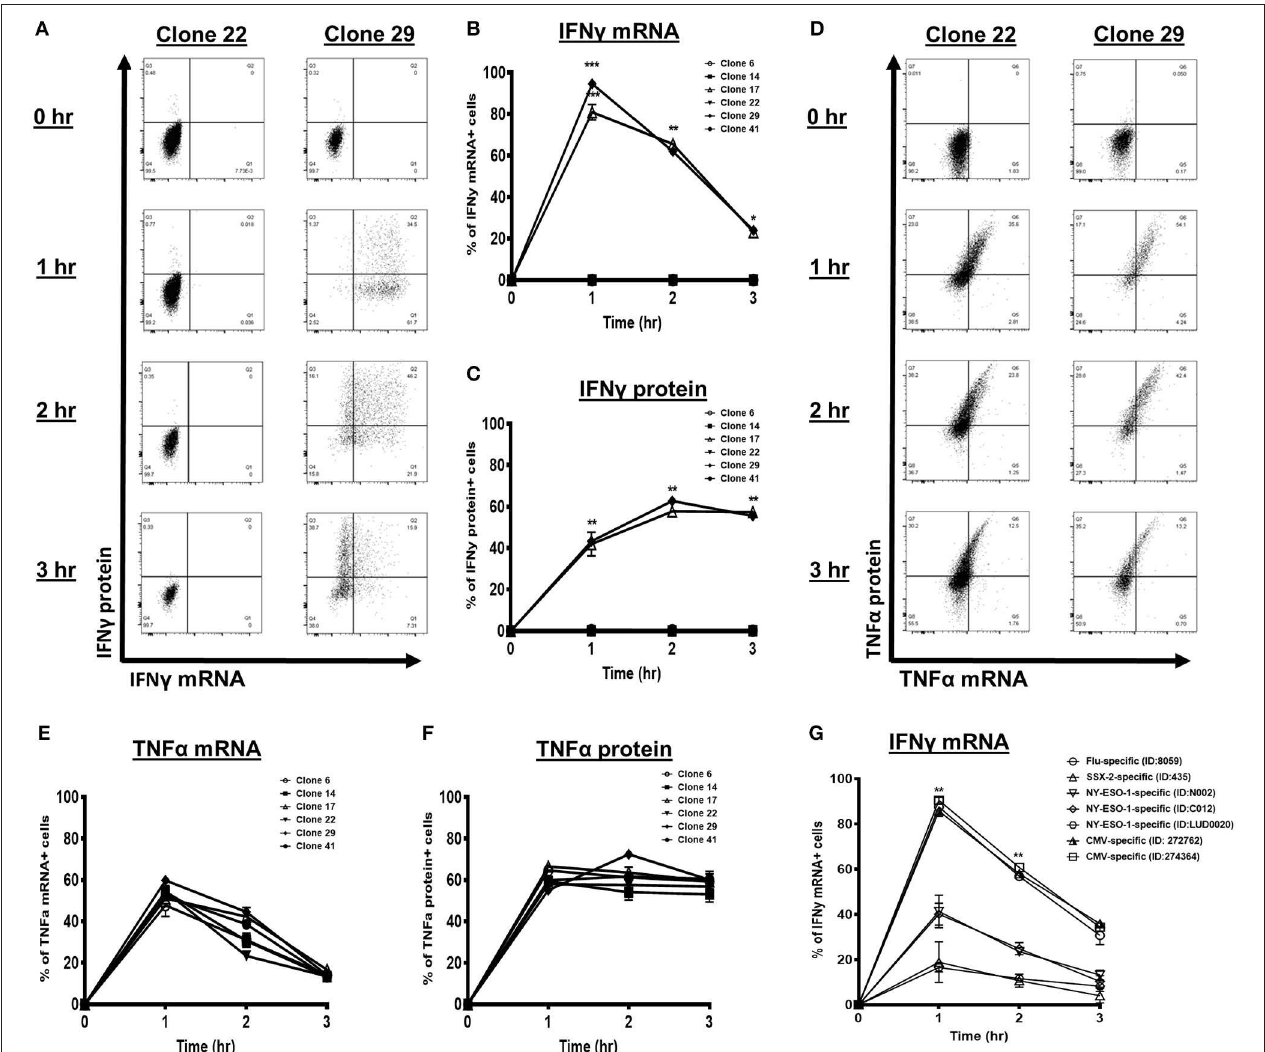
FIGURE 4 | Interferon gamma (IFN γ ) kinetics of synovial sarcoma X (SSX)-2-specific T cell clones and short-term expanded bulk antigen-specific cytotoxic T lymphocytes (CTLs). (A) Flow cytometry dot plots of IFN γ mRNA and protein levels following co-culture with CD3/CD28 activator antibody at the indicated time points. Proportion of cells with IFN γ mRNA (B) and protein (C) following co-culture with CD3/CD28 activator antibody at the indicated time points. (D) Histogram plots of TNF α mRNA and protein levels following co-culture with CD3/CD28 activator antibody at the indicated time points. Proportion of cells with TNF α mRNA (E) and protein (F) following co-culture with CD3/CD28 activator antibody at the indicated time points. (G) IFN γ mRNA level of each antigen-specific T cell type [influenza-specific T cells, cytomegalovirus (CMV)-specific T cells, SSX-2-specific T cells, and New York-esophageal squamous cell carcinoma-1 (NY-ESO-1)-specific T cells derived from different patients] following treatment with CD3/CD28 activator antibody for 0, 1, 2, and 3h. N , number of experimental repeats = 3. * P < 0.05, ** P < 0.01, *** P < 0.001; analysis performed with two-way ANOVA with Tukey’s multiple comparison.